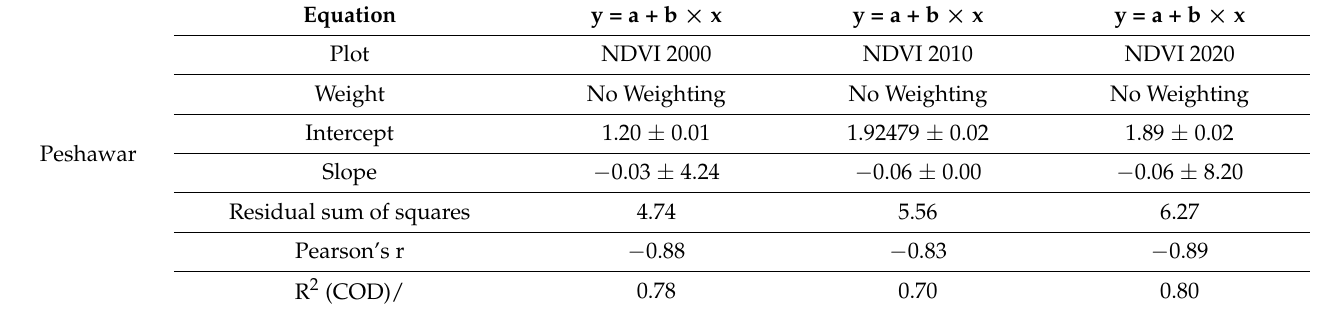
Table 4. Linear regression analysis over the sites (a, b, and